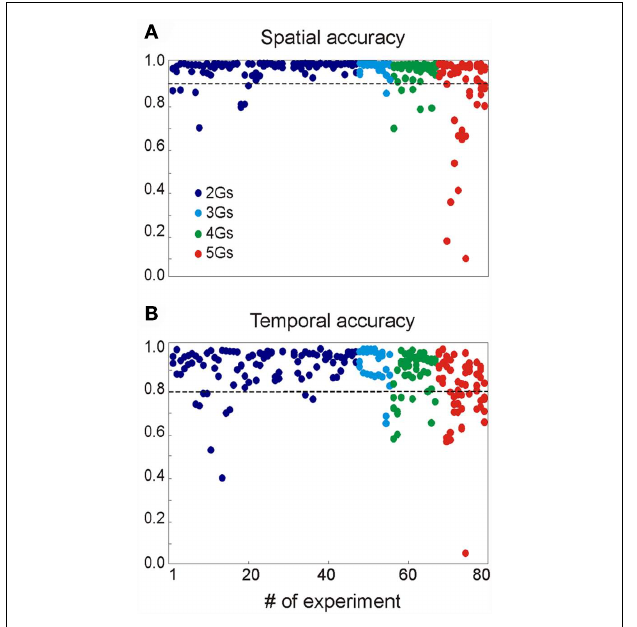
FIGURE 3 | Summary of the results obtained for 80 multisynaptic LFPs. The plots show the spatial (A) and temporal (B) accuracy of each generator derived from mixed LFPs when compared to their values alone (see Methods).The values of the different generators obtained in each simulation are represented by the dots in the same vertical position.The parameters for the synaptic combinations can be found in the Appendix.